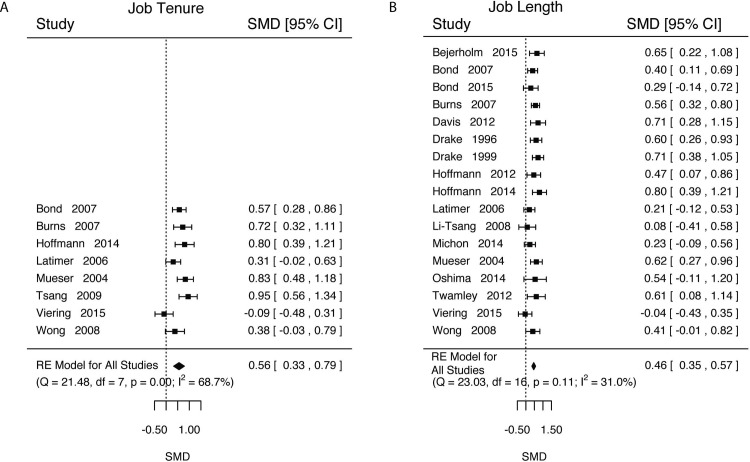
Competitive employment job tenure and job duration results.A) Job tenure, which is the duration of the longest held competitive employment job. B) Job duration, which is the total length of competitive employment.